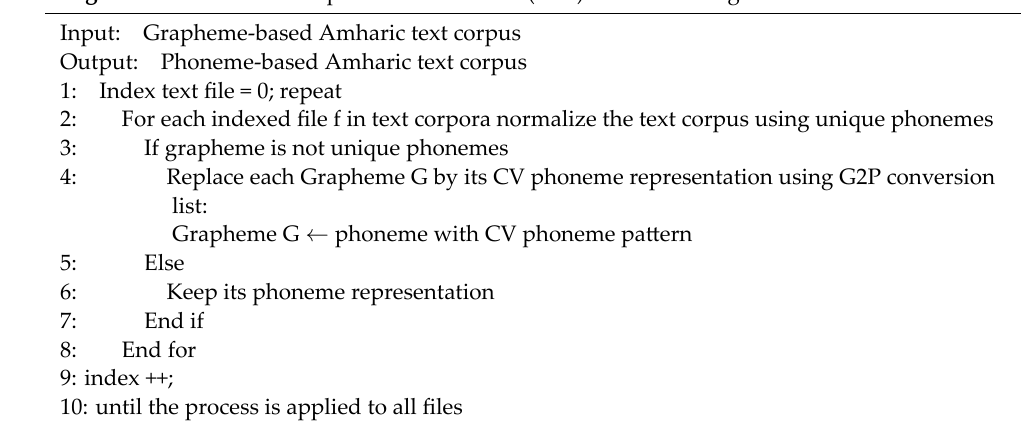
Algorithm 1: Amharic Grapheme‑to‑Phoneme (G2P) Conversion algorithm